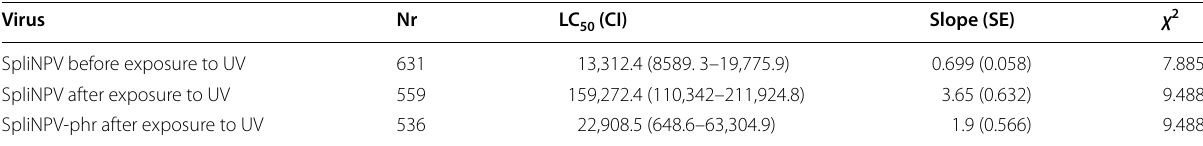
Table 1 Median lethal concentration (LC viruses after 7 days